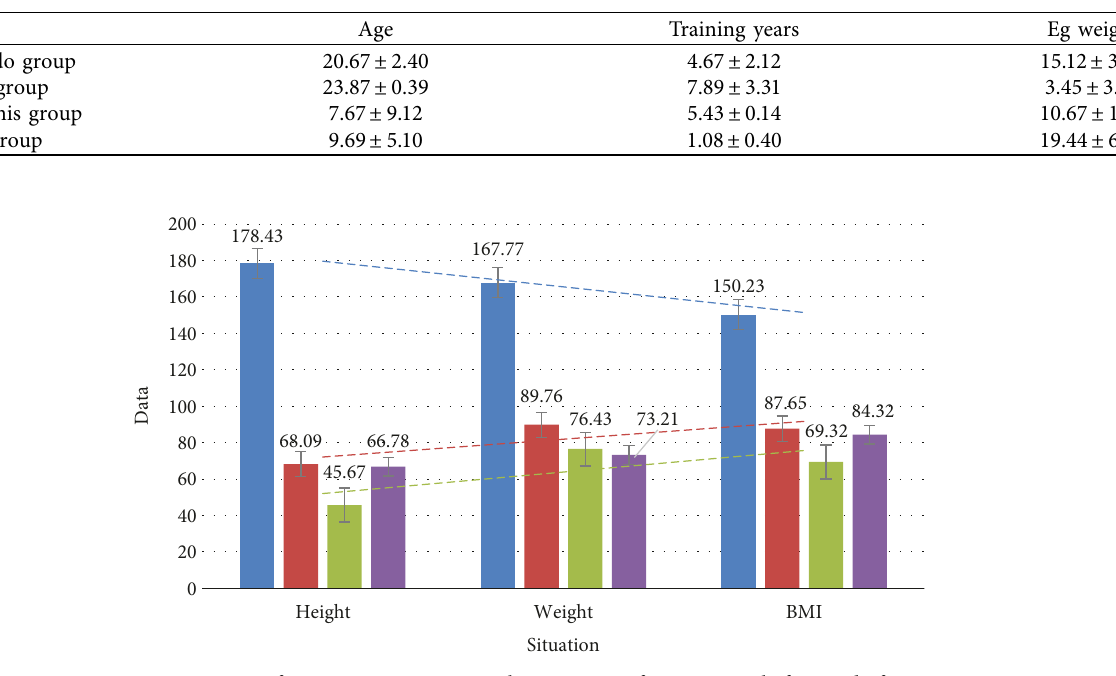
Table 3: Subject information.